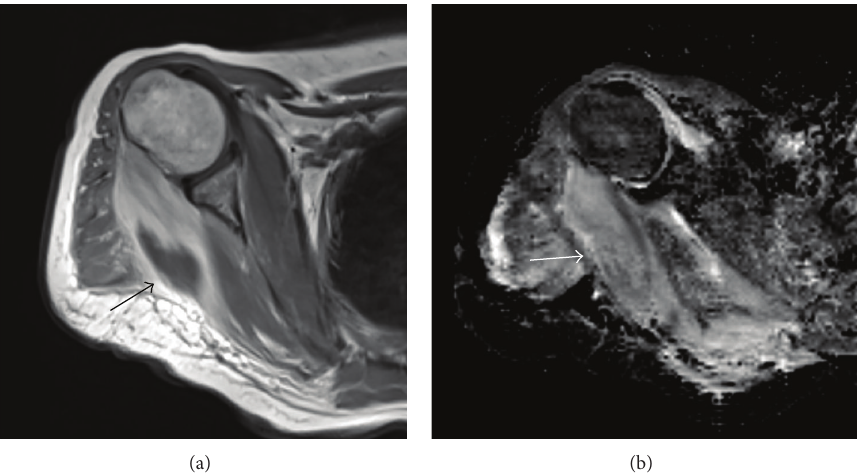
Figure 1: (a) Axial MRI image of the Rhizopus abscess. Contrast enhanced T1W image shows thickening of the teres minor and major muscles with heterogeneous enhancement and hypointense central area of necrosis suggestive of abscess (black arrow). (b) High signal in the ADC ap of DW sequence ( 𝑏 = 600 s/mm 2 in the diffusion (white arrow) (MRI: magnetic resonance imaging; T1W: t1 weighted; ADC: apparent diffusion coefficient; DW: diffusion-weighted)).